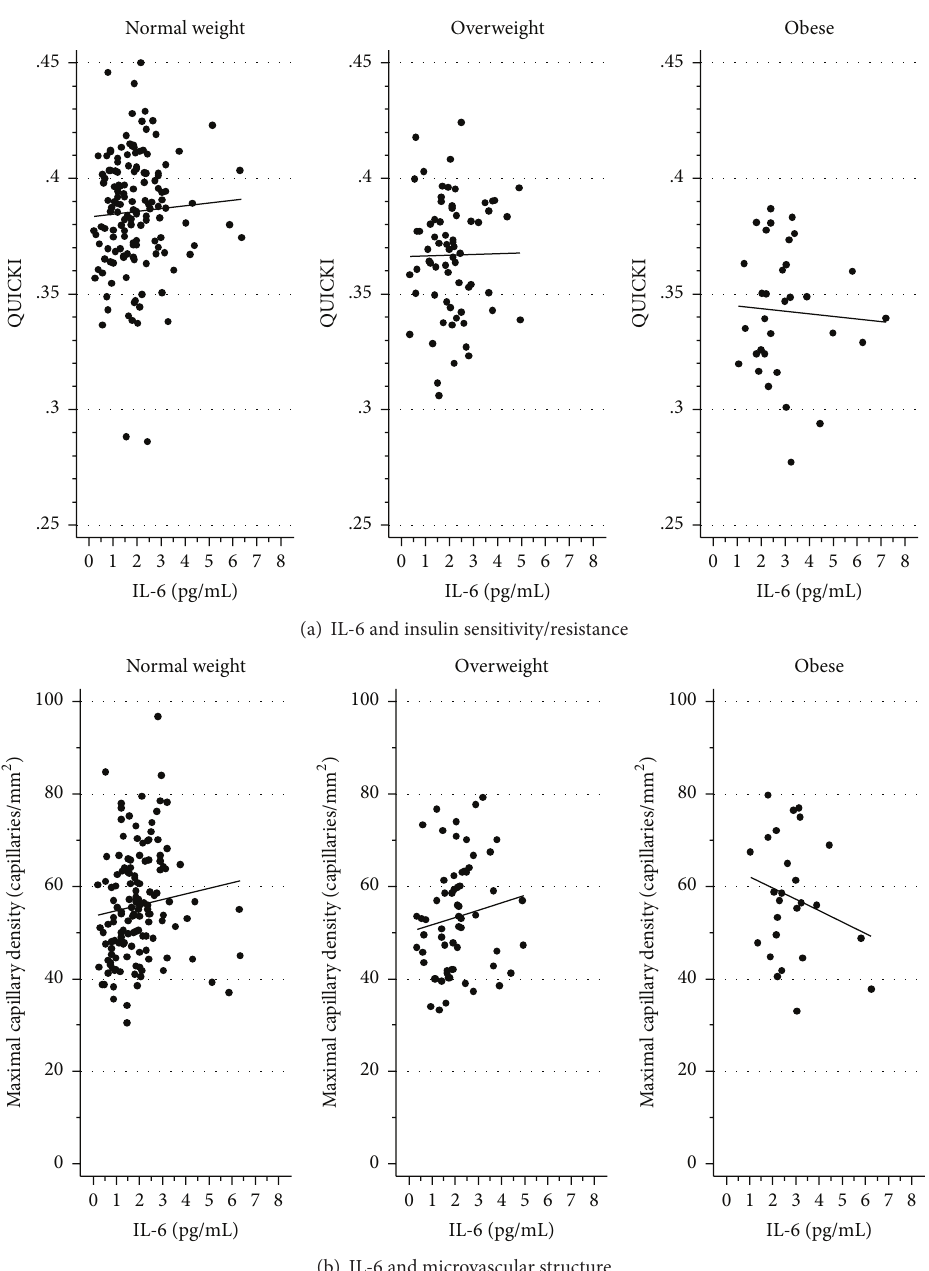
Figure 1: Association of IL-6 with insulin sensitivity/resistance (a) and microvascular structure (b), among normal-weight, overweight, and obese